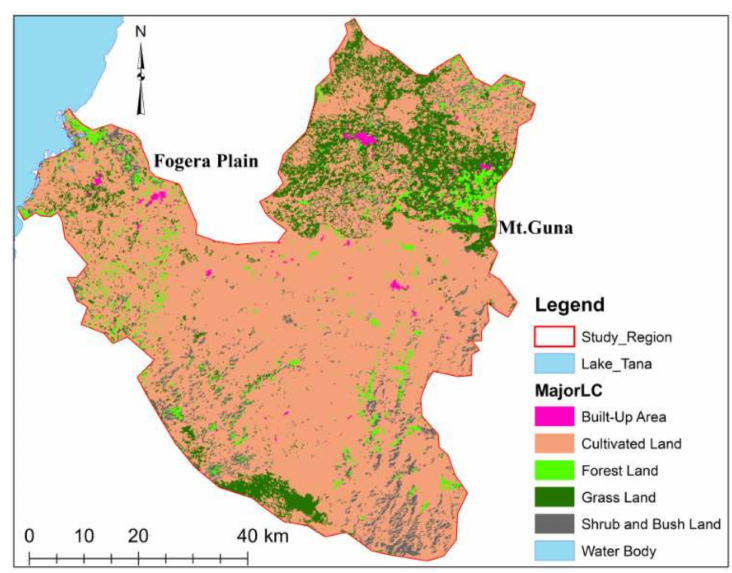
Figure 5. Land use map of study